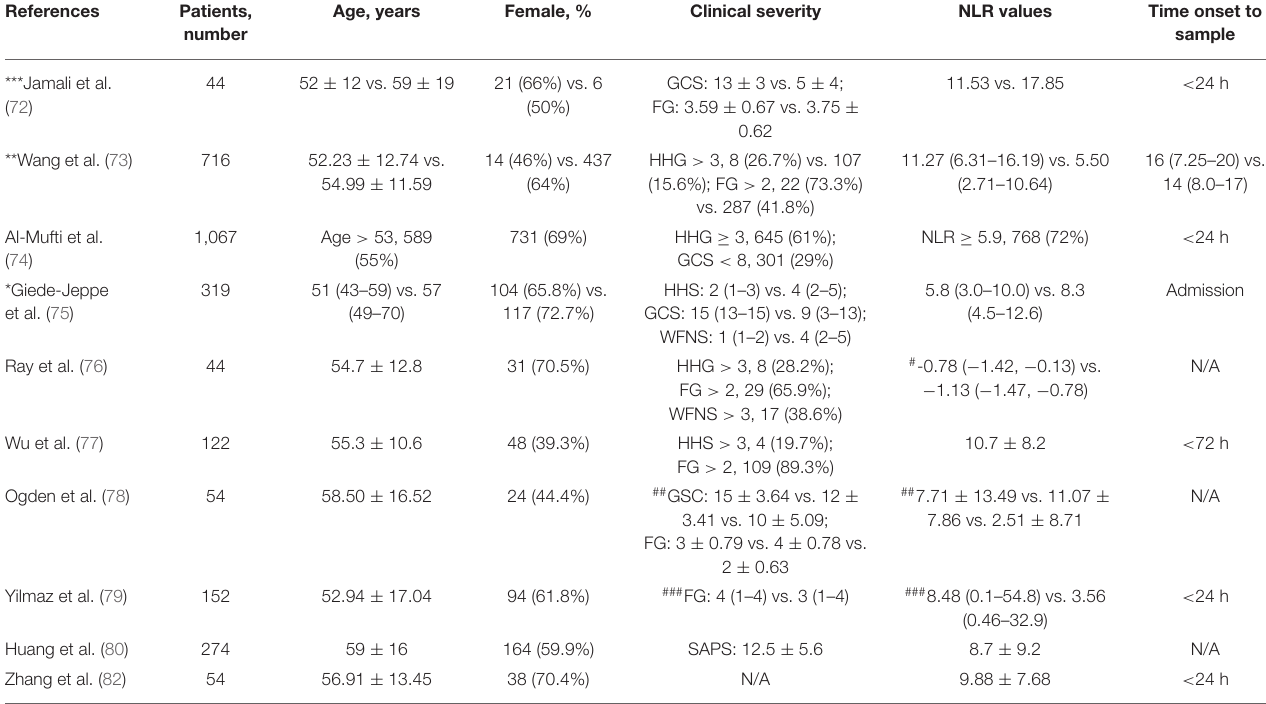
TABLE 2 | Characteristics of the included